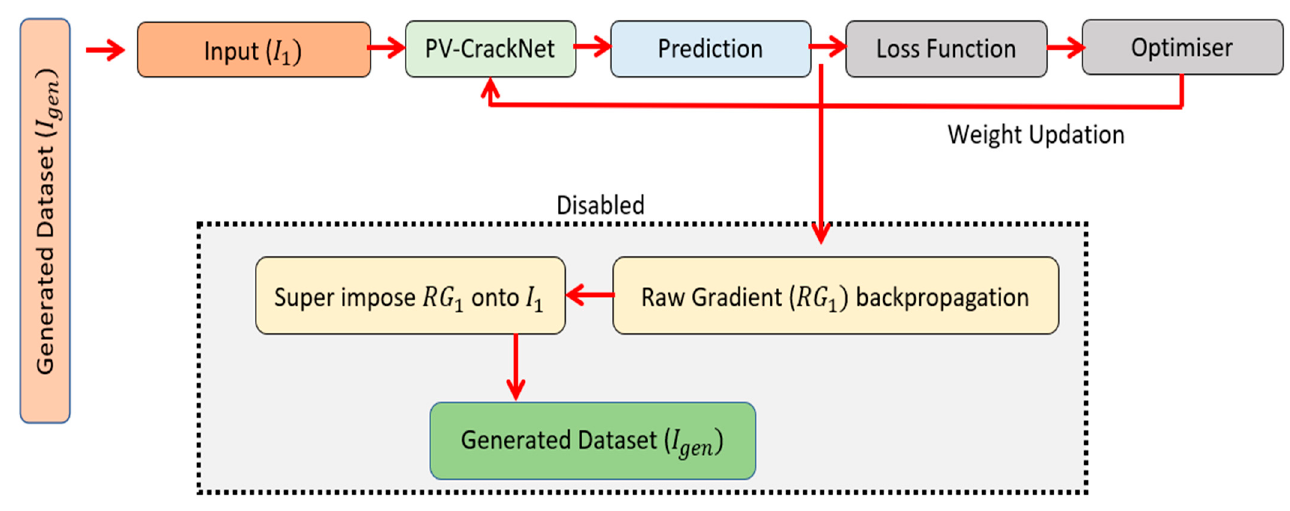
Figure 9. Optimizer reactivation.